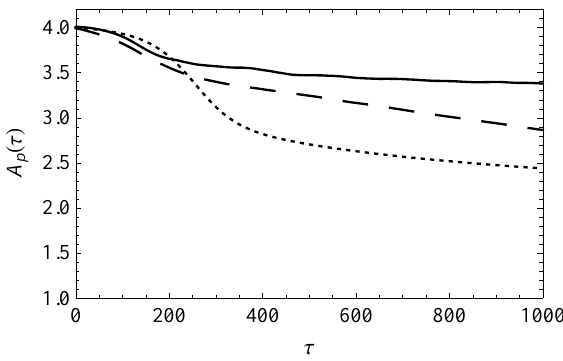
Fig. 7. Proton thermal anisotropy for standard (cid:15) = 0 (solid) and ex- panding box (cid:15) = 10 − 4 (dashed) hybrid simulations. Here it can be seen that the expansion effects are notable only from long enough times during the simulation. In order to compare, the anisotropy for the quasilinear solution is also included (dotted curve).